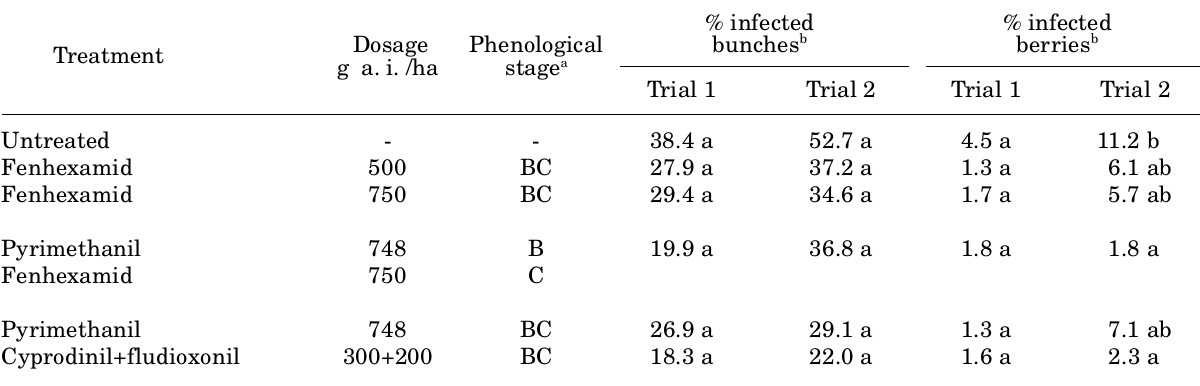
Table 9. Efficacy of different fungicides against Botrytis cinerea on grapevine, cv. Moscato. Trial 1: Saracco Farm, Castiglione Tinella; Trial 2: Aimasso Farm, Valdivilla,